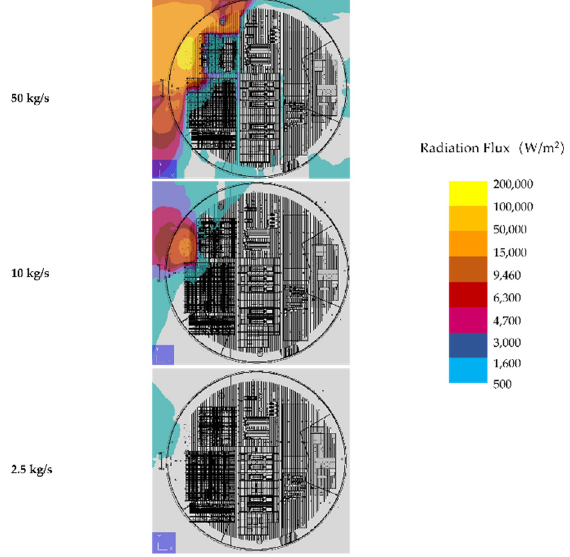
Figure 13. Leak 1 jet fire results—Leak Down—XY Slice z = 41 m (process deck 1st floor) radiation flux (W/m 2 ).